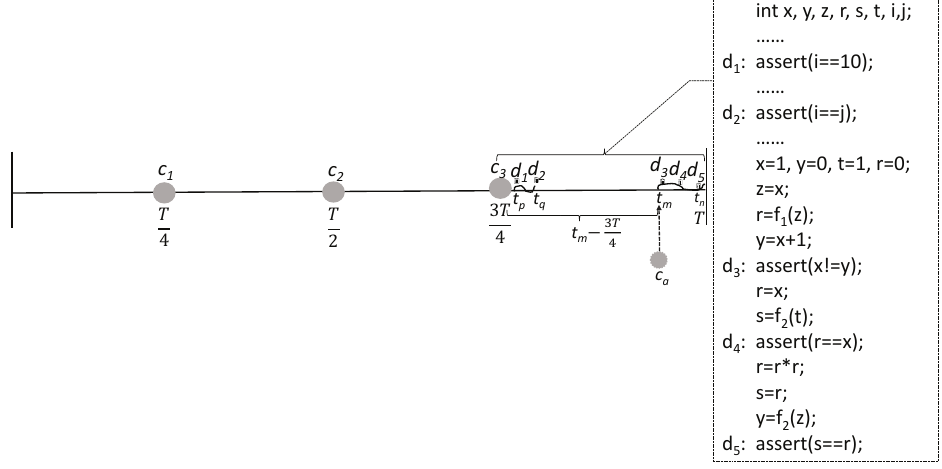
Figure 3. An example of